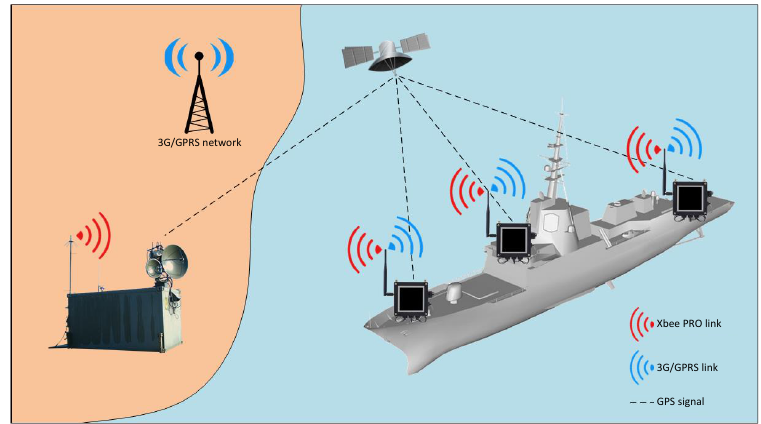
Figure 3. System operation overview.